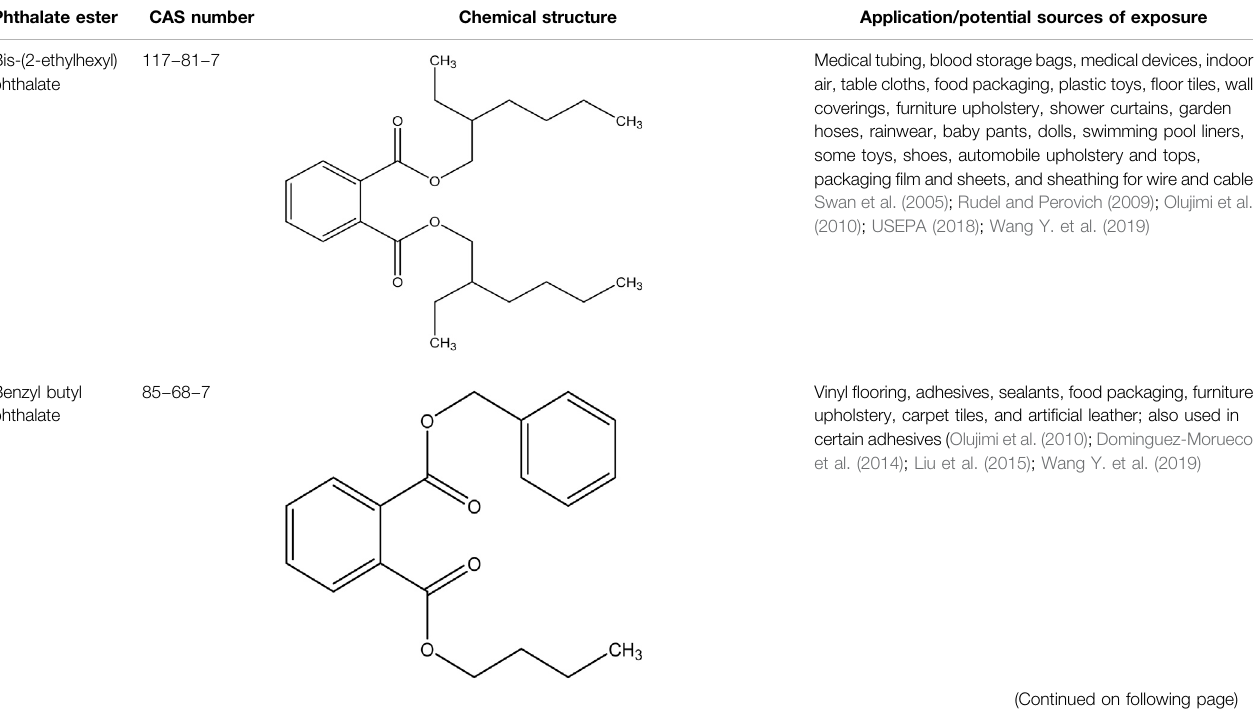
TABLE 1 | Applications and potential sources of exposure for some of the most commonly used